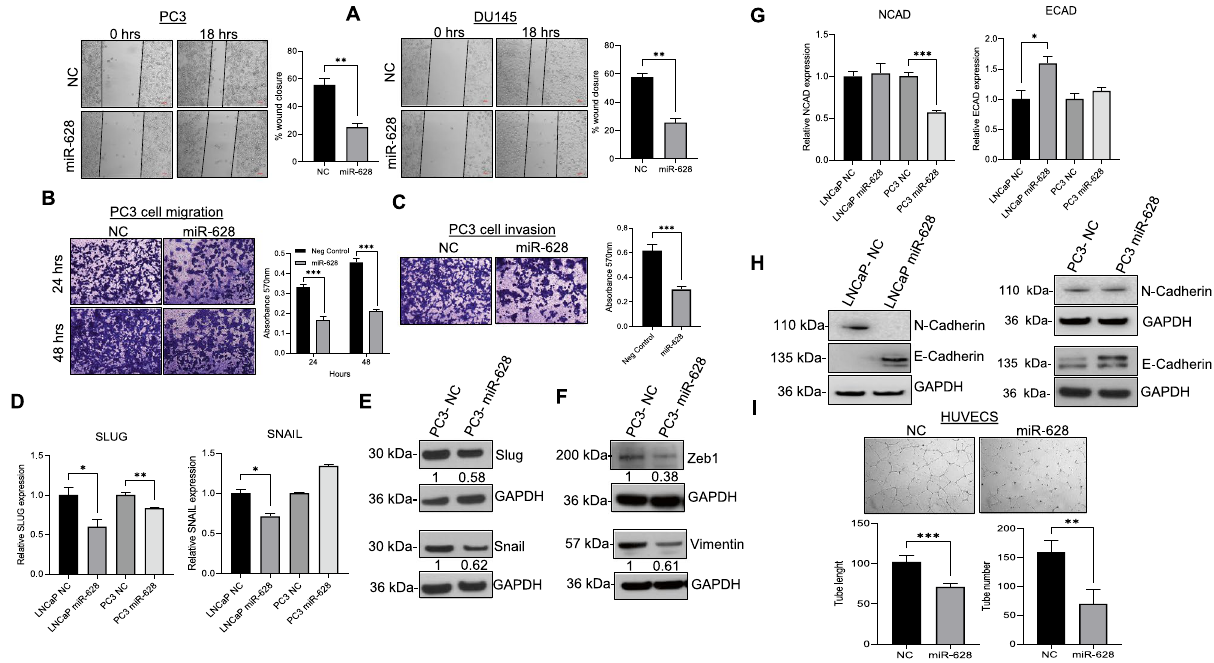
Figure 6. MiR-628 expression affects PCa cell migration, invasion, and tube formation in PCa and HUVEC cells. ( A ) Cell motility assay (scratch assay) was performed in PC3 and DU145 cells transfected with miR-628 (100 nM) or NC (100 nM) (representative images, left panels) and scratch closure was quantified after 18 h using ImageJ (right panels; **p < 0.01). ( B ) Transwell cell migration was assessed in PC3 cells transfected with miR-628 or NC. Representative images are shown in upper panels taken at 10X magnification with a light microscope. Absorbance (562 nm) was determined at 24 and 48 h (lower panels) as described in the material and method section. ***p < 0.001. ( C ) Cell invasion assay assessed in PC3 cells transfected with miR-628 (100 nM) or NC (100 nM) (upper panels) and absorbance (562 nm) was determined at 48 h (lower panels; ***p < 0.001). Images were taken at a 10X magnification with a light microscope. ( D ) The effect of miR-628 on the expression of SLUG and SNAIL expression was measured by RT/qPCR in LNCaP and PC3 cells after transfection with 100 nM of miR-628 mimic or NC. *p < 0.05, **p < 0.01. ( E ) Protein expression of Slug and Snail are shown in PC3 cells after transfection with 100 nM of miR-628 mimic or NC and imaged using film. ( F ) Protein expression of Zeb1 and Vimentin are shown in PC3 cells after transfection with 100 nM of miR-628 mimic or NC and imaged using film. ( G ) The effect of miR-628 on the expression of E-cadherin ( ECAD) and N-cadherin ( NCAD) was measured by RT/qPCR in LNCaP and PC3 cells after transfection with 100 nM of miR-628 mimic or NC (left panels). *p < 0.05, ***p < 0.001 ( H ) E-cadherin and N-cadherin protein expression was analyzed by Western blotting as described in the materials and methods section after transfection with 100 nM of miR-628 mimic or NC. Membranes were cut before hybridization using the molecular weight marker as a reference and imaged using an Azure imaging system. All western blot full images are provided in supplementary information files. ( I ) Angiogenesis was determined in HUVEC cells transfected with miR-628 or NC (upper panels). Representative images were captured using an inverted light microscope and representative images are shown at 20 × magnification. The tube length and number were determined at 24 h using ImageJ (lower panels; **p < 0.01, ***p <